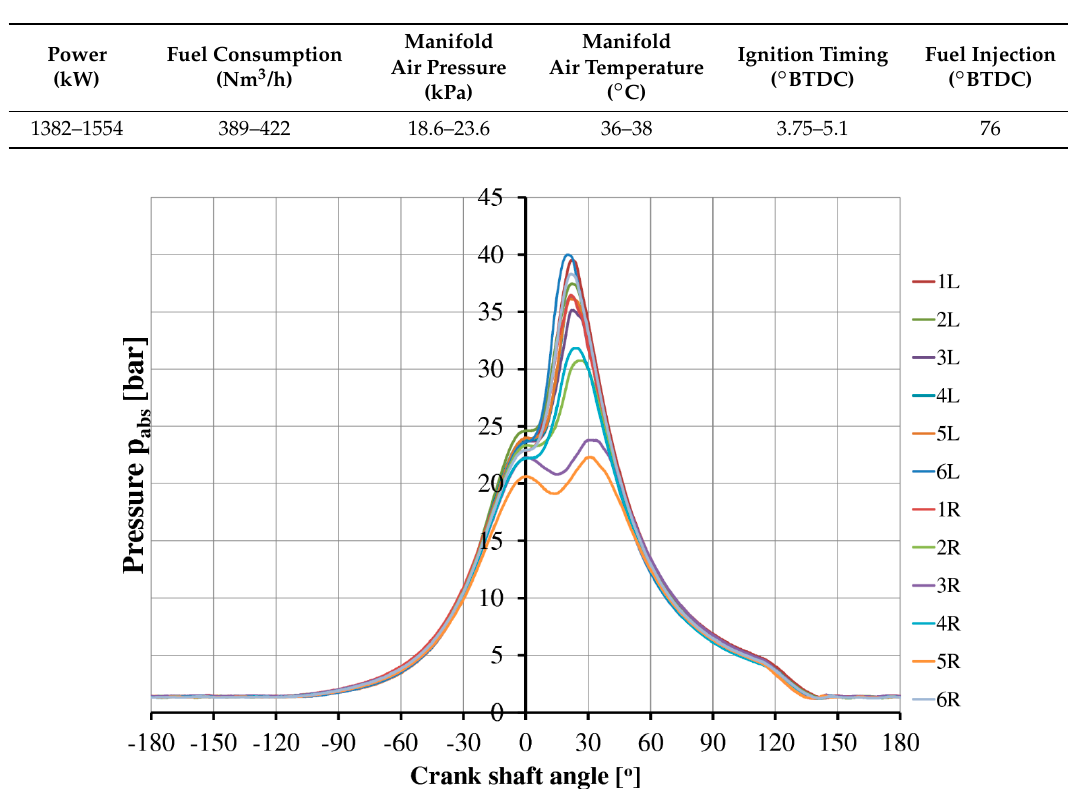
Table 4. Work parameters of GMVH-12 engine.